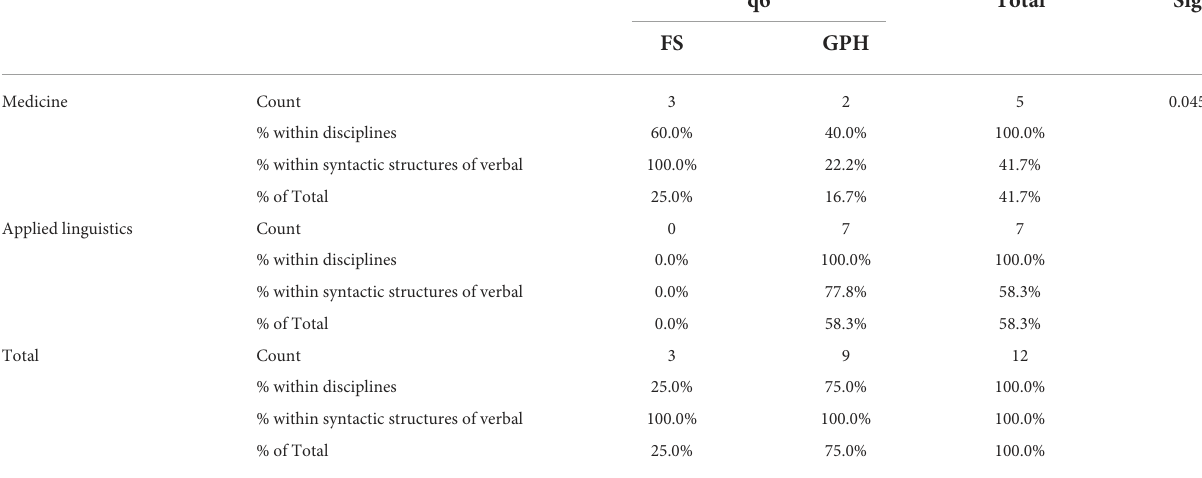
TABLE 6 Frequency and percentage of syntactic structures of verbal constructions in single-unit titles in the two disciplines (chi-square test).